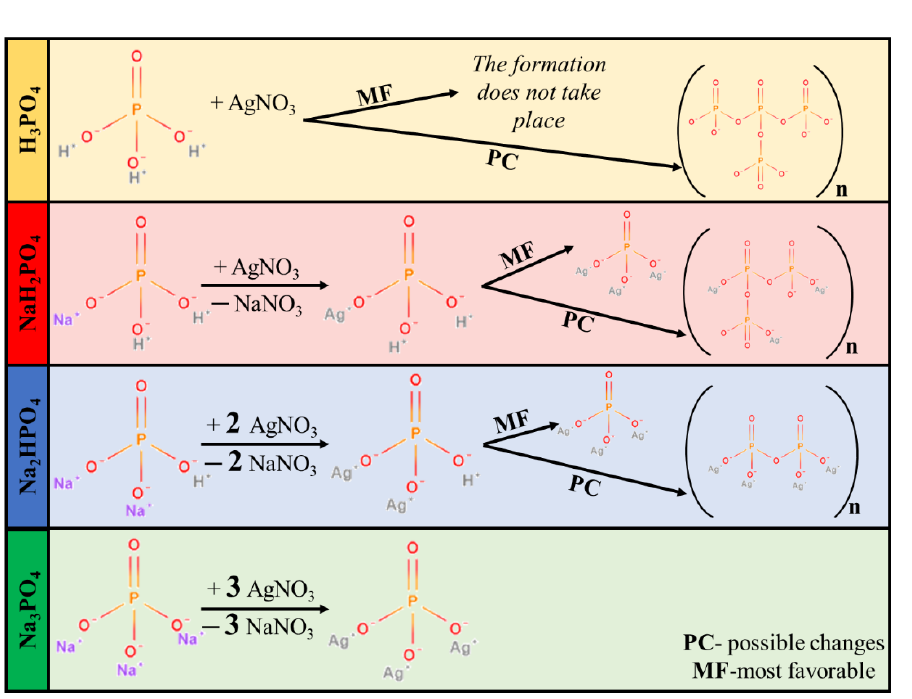
Figure 1. Proposed mechanism of Ag 3 PO 4 formation. Table 1. pH, band gap energy, absorption band maxima, average particles sizes, and conversion values of the obtained Ag 3 PO 4 samples (n.a. — no available).